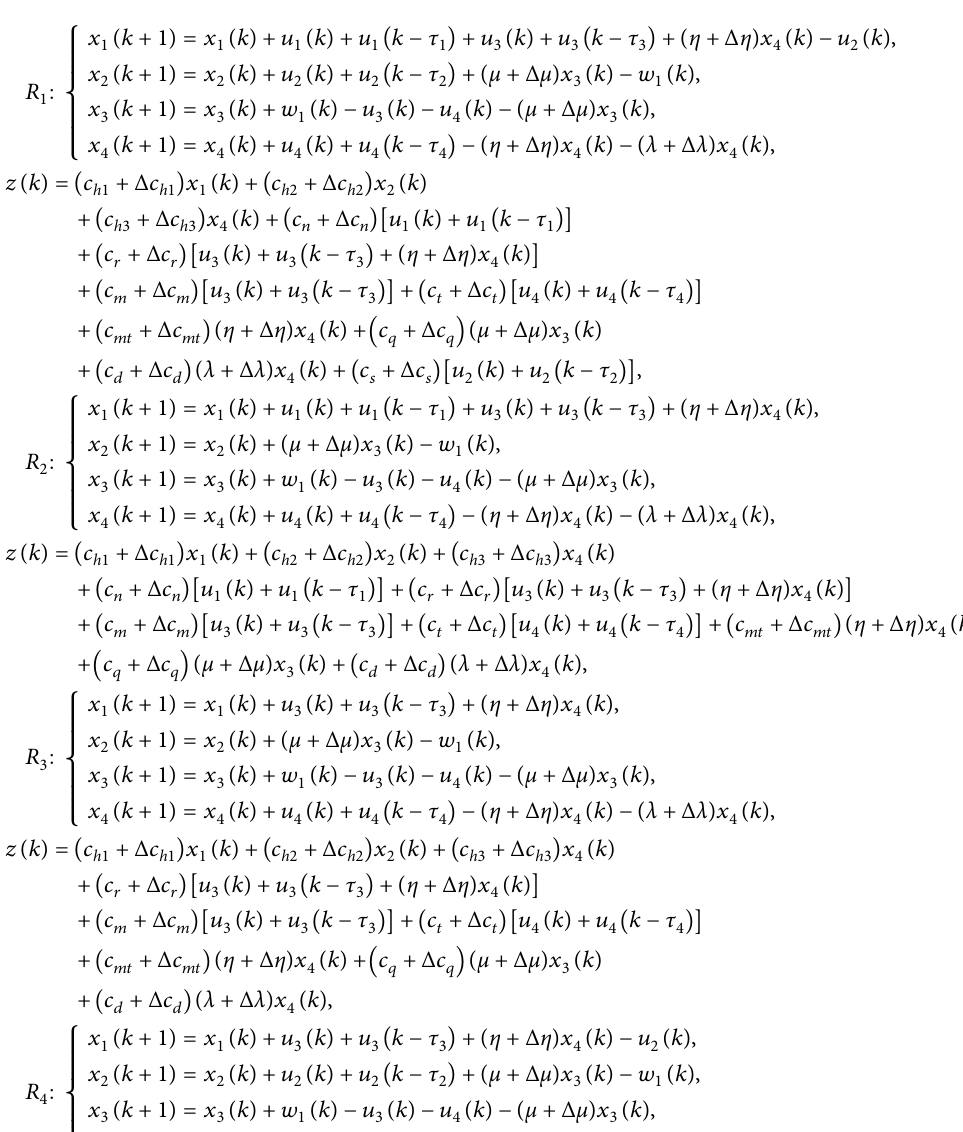
Figure 2: Fuzzy membership